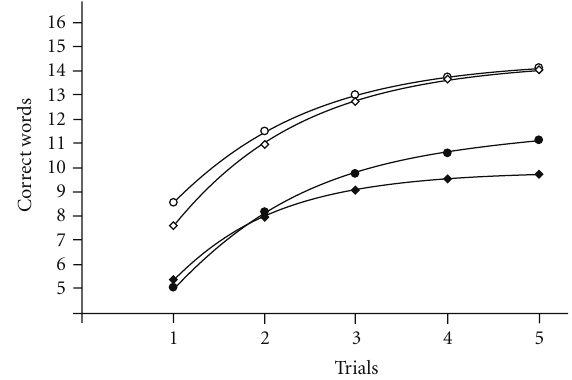
Figure 7: The averaged learning curves over cluster referring to lower memory functioning and cluster referring to higher memory functioning for healthy female participants and MS female patients, using B 3 or B 4. Empty circles—cluster referring to higher memory functioning using B 3 in healthy female participants; B 2 = 0.69; B 3 = 8.56; B 4 = 14.43. Empty diamonds—cluster referring to higher memory functioning using B 4 in healthy female participants; B 2 = 0.66; B 3 = 7.67; B 4 = 14.63. Filled circles—cluster referring to lower memory functioning using B 3 in MS female patients; B 2 = 0.63; B 3 = 5.06; B 4 = 11.62. Filled diamonds—cluster referring to lower memory functioning using B 4 in MS female patients; B 2 = 0.86; B 3 = 5.41; B 4 = 9.88. In healthy female participants B 3 is higher in cluster referring to higher memory functioning using B 3 ( P = . 019) in comparison with cluster referring to higher memory functioning using B 4. In MS patients B 4 ( P = . 003) is higher in the cluster referring to lower memory functioning using B 3 versus cluster referring to lower memory functioning using B 4. B 3 ( P = . 00005) and B 4 ( P = . 0008) di ff ers highly significant between cluster referring to higher memory functioning for healthy females and cluster referring to lower memory functioning for MS females using B 3. Besides B 3 ( P = . 0006) and B 4 ( P = . 0002) di ff ers highly significant between cluster referring to higher memory functioning for healthy females and cluster referring to lower memory functioning for MS females using B